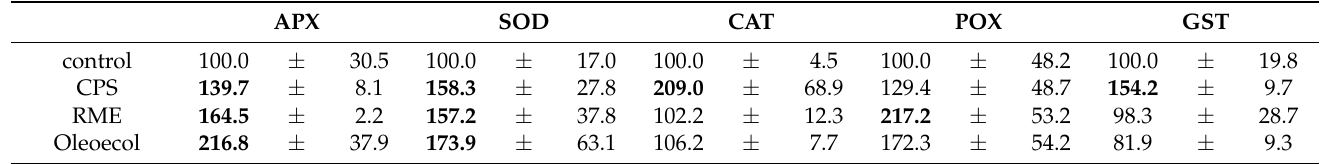
Table 3. Activity of antioxidant enzymes (APX—ascorbate peroxidase; SOD—superoxide